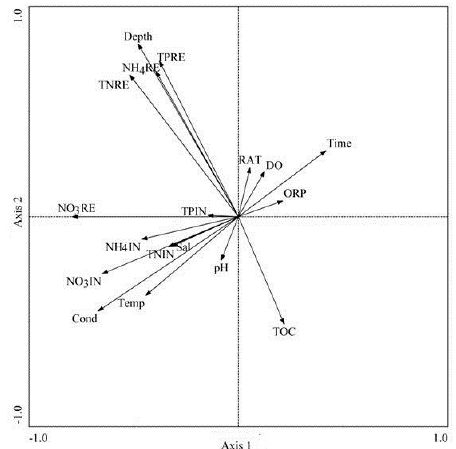
Figure 7. RDA ordinations for various environmental factors in the TF-CW simulator. Note: TNRE: